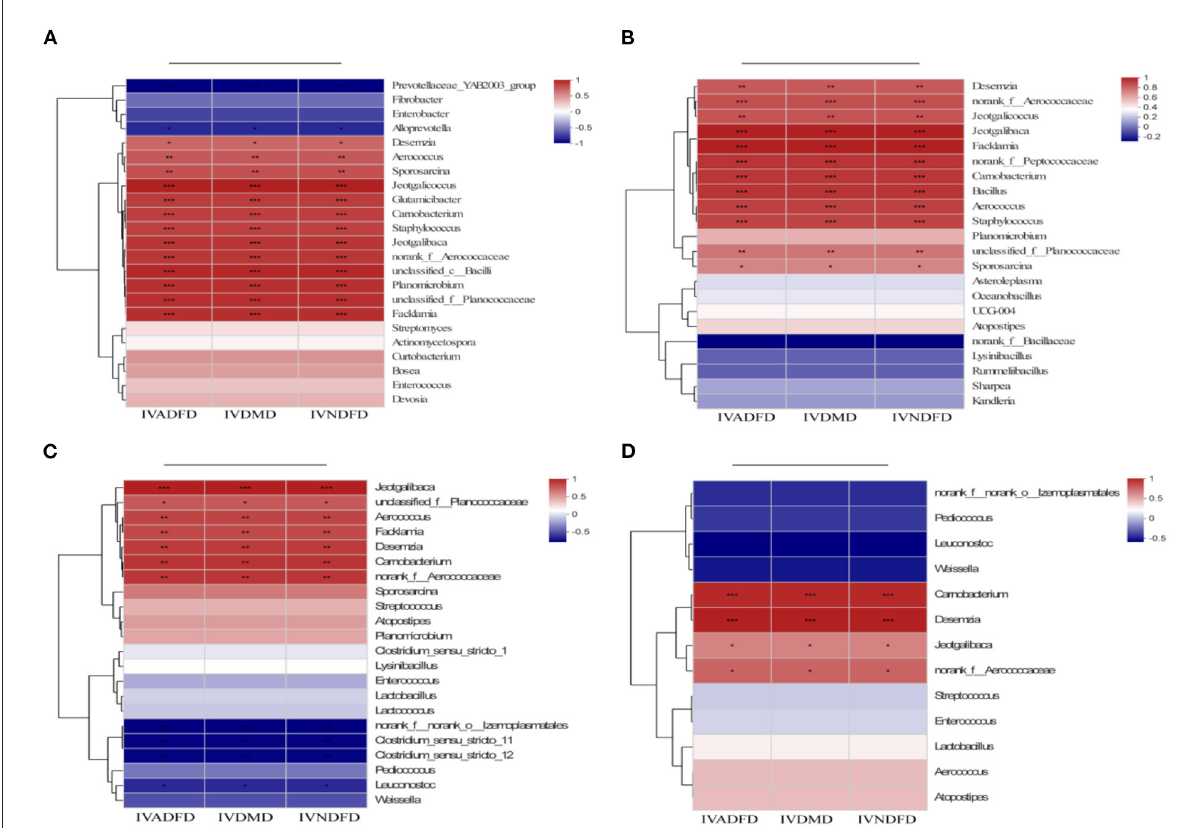
FIGURE7 Correlations heatmap of top 30 genera in colonization on surface of rice straw during incubation in rumen 0.5h (A) , 4h (B) , 12h (C) , and 24h (D) and environmental factors. Con: no pretreatment for control group, Ca: 4% Cao, UCa: 2.5% urea + CaO, CUCa: 9% CSL + 2.5% urea + 4% CaO. * , ** , and *** indicated the significant correlations at P < 0.05, 0.01, and 0.001. IVDMD, in vitro dry matter degradability; IVNDFD, in vitro neutral detergent fiber degradability.